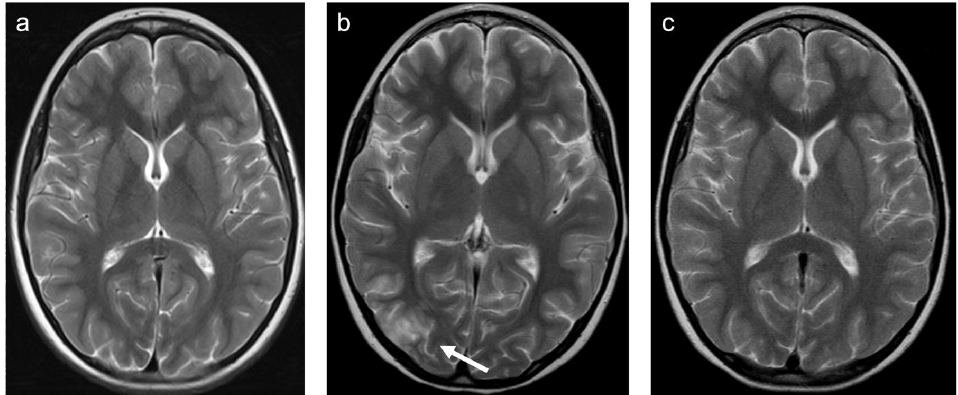
Figure 8. Representative case “Toxic white matter injuries”: L -asparaginase treatment. T2W ( a – c ) sequences. ten-year-old boy with induction of L-asparaginase treatment of acute lymphoblastic lym- phoblastic leukemia. MRI prior to treatment ( a ), shortly after induction of treatment showing vasogenic edema within the right (white arrow) and, of lesser extent, left occipital region (( b ); clinical presentation: epileptic seizure) with patchy enhancement in a leptomeningeal pattern (not shown) and restitution after treatment stop ( c ).